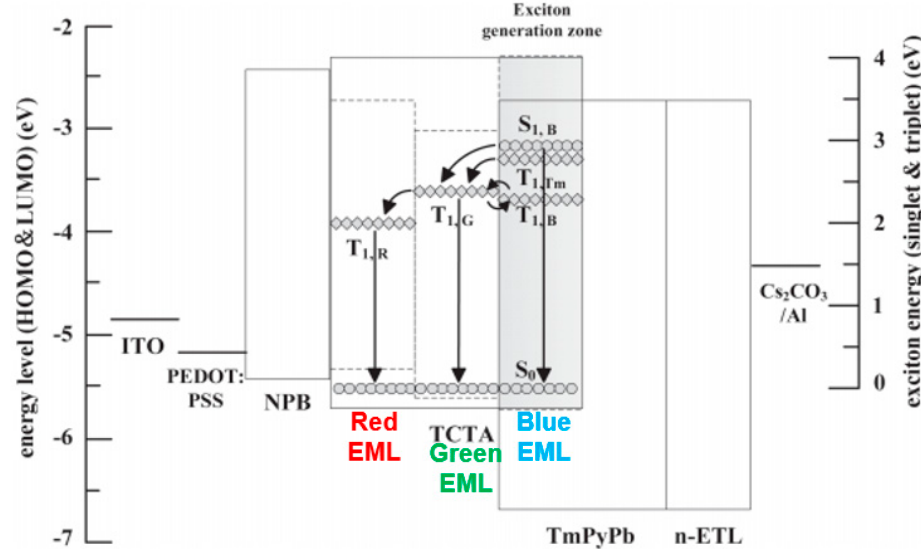
Figure 21. The device structure, energy levels, and EL processes. The main exciton generation zone was marked by gray color. m is TmPyPB. Reproduced from Reference [201].